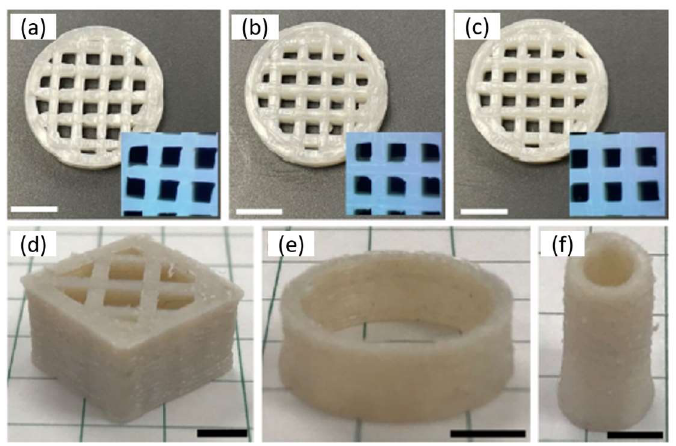
Figure 7. ( a – c ) Photos of 3D-printed cylinders with infill patterns from the SIBS/PS blends: ( a ) SIBS/PS (77/23), ( b ) SIBS/PS (67/33), and ( c ) SIBS/PS (57/43). The insets show higher-magnification images taken with an optical microscope. ( d – f ) 3D-printed objects with different shapes from SIBS/PS (57/43). Scale bars are 5 mm. Reprinted with permission from [99].